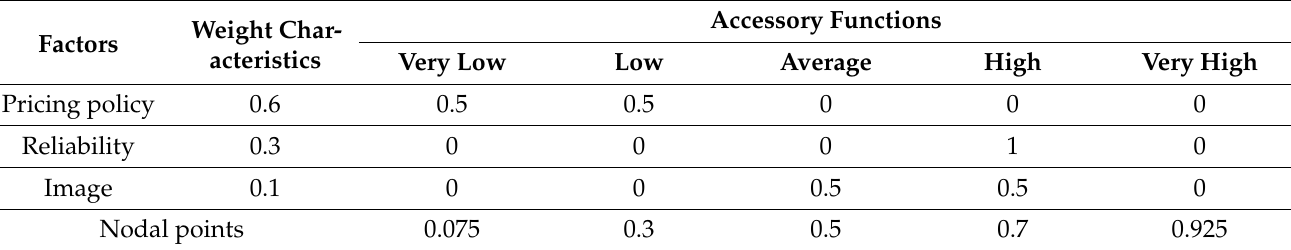
Table 4. Matrix required for conducting an integral assessment of the impact of the “suppliers” factor on the financial strategy of PJSC